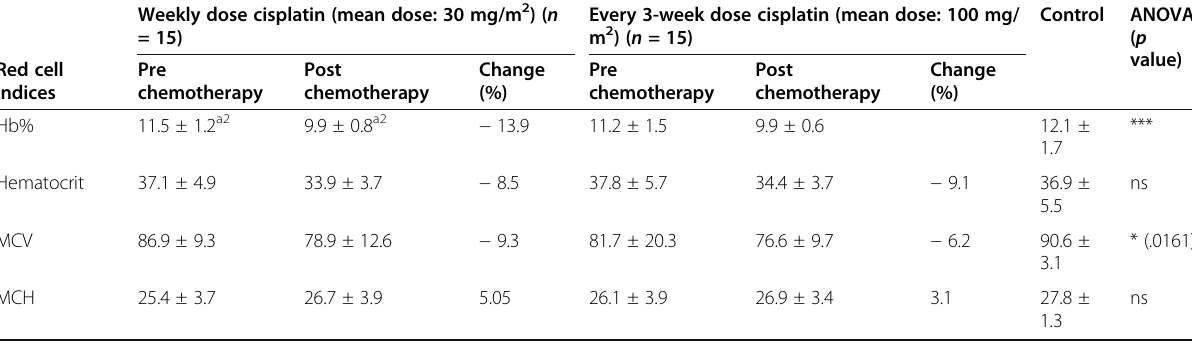
Table 3 Red cell indices of LASCCHN patients in both the groups Weekly dose cisplatin (mean dose: 30 mg/m 2 ) ( n =